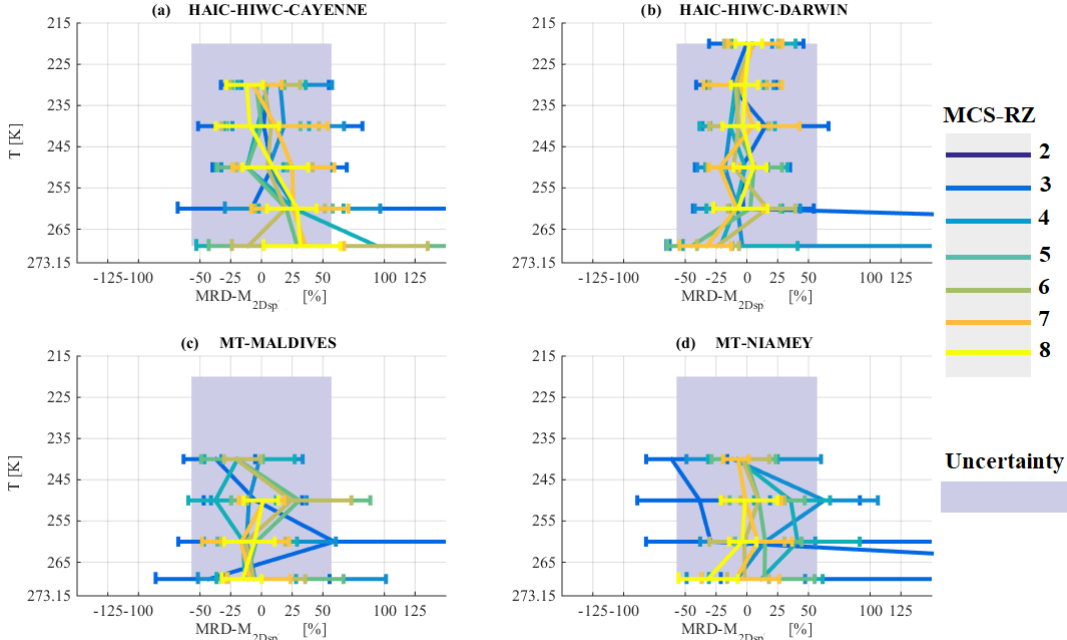
Figure E2. The same as Fig. 6 but for MRD- M 2 , Dsp , where PSD is used as a function of equivalent spherical